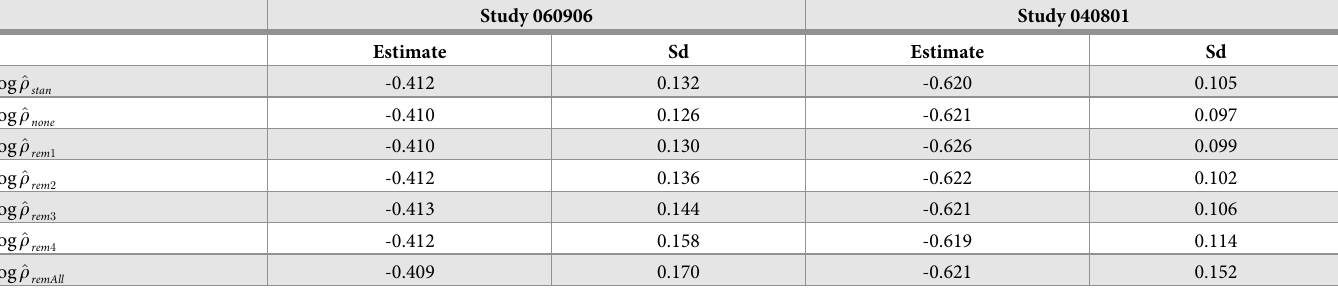
Table 2. Results from the mixed-effects meta-analysis based on 1000 simulations. Estimates and standard errors for the relative log-potency of the insulin analogue compared to HI for study 060906 (insulin analogue 32) and 040801 (insulin analogue 7) are shown for different ways of re-fitting the simulated data: none and all indicate keeping and removing all the control rats, respectively, rem1 indicate removing one control rat per dose value, rem2 indicate removing two and so